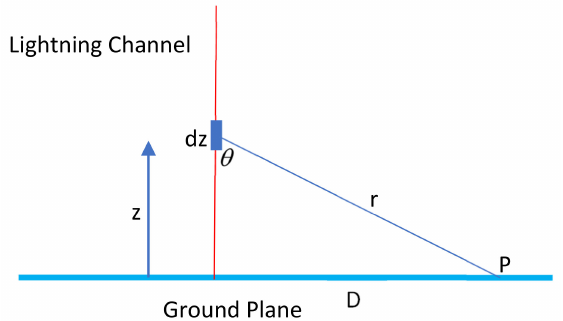
Figure 2. The geometry relevant to the calculation of the electromagnetic